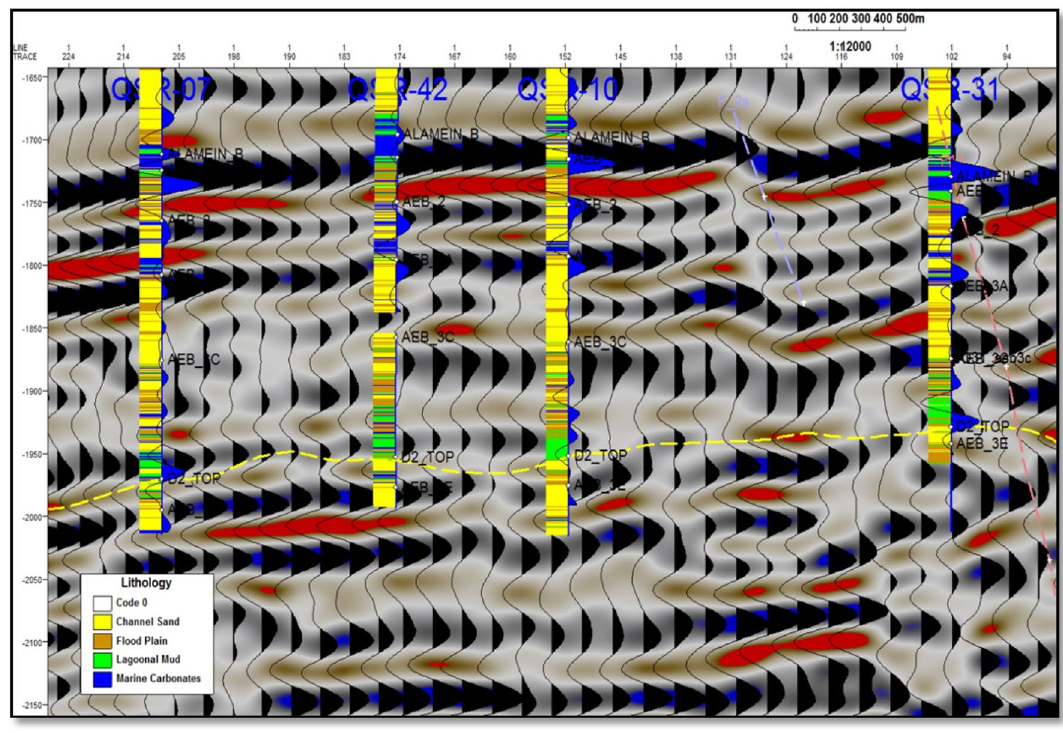
Fig. 14 NE–SW seismic section along wells Qasr-07–42–10–31. Lithology and synthetic positive amplitude (blue) are displayed in each well. Amplitude wiggles are displayed (black wiggles are positive amplitudes). Top D2 sand unit in dashed yellow